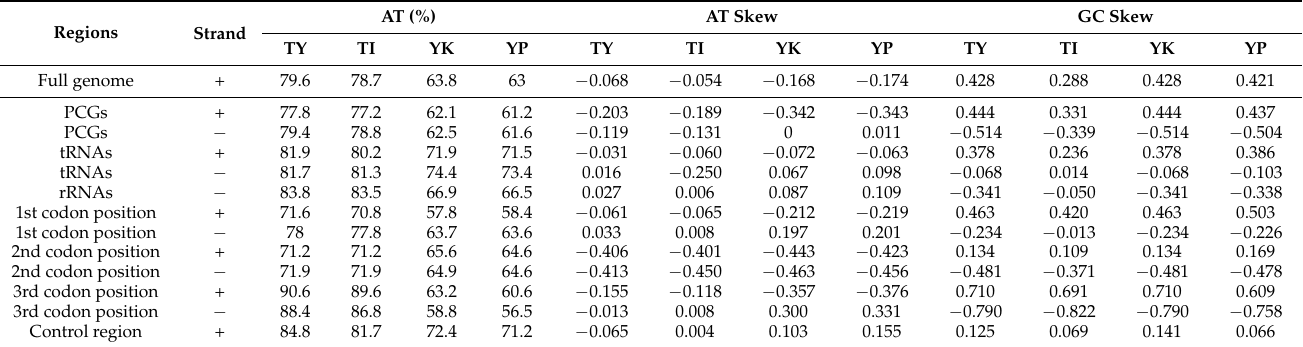
Table 4. A + T content (%), AT and GC skewness of four Mysmenidae species mitogenomes.